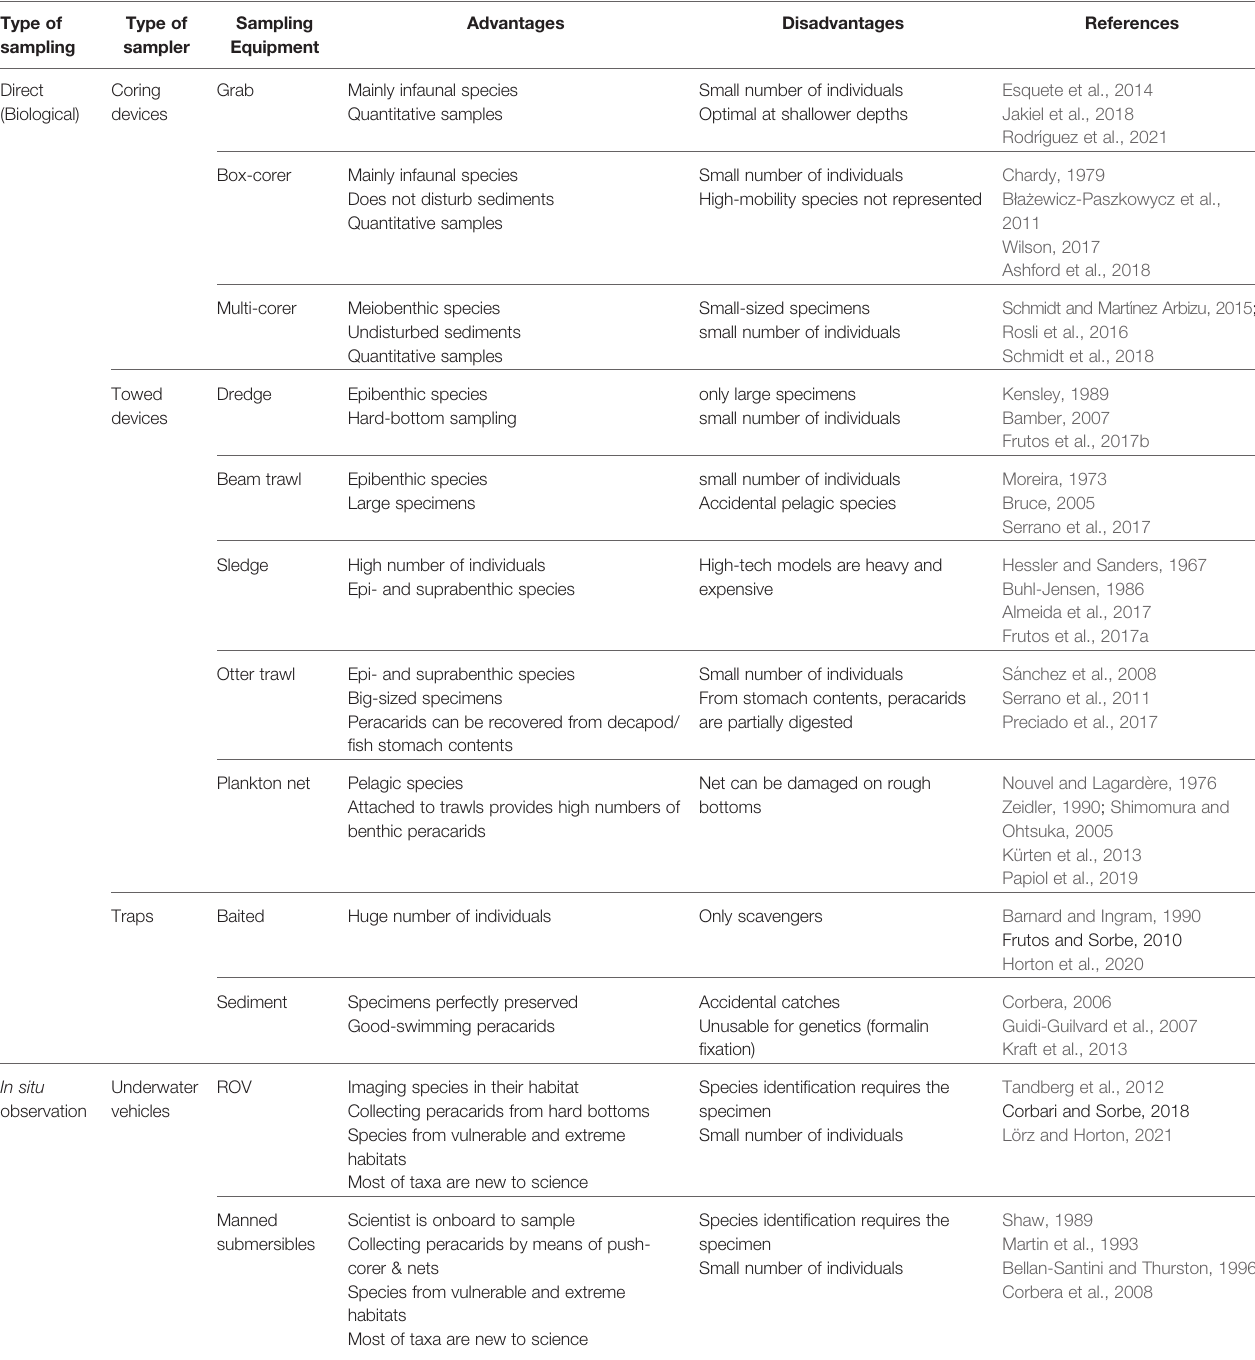
TABLE 1 | The most common types of sampling devices used for collecting